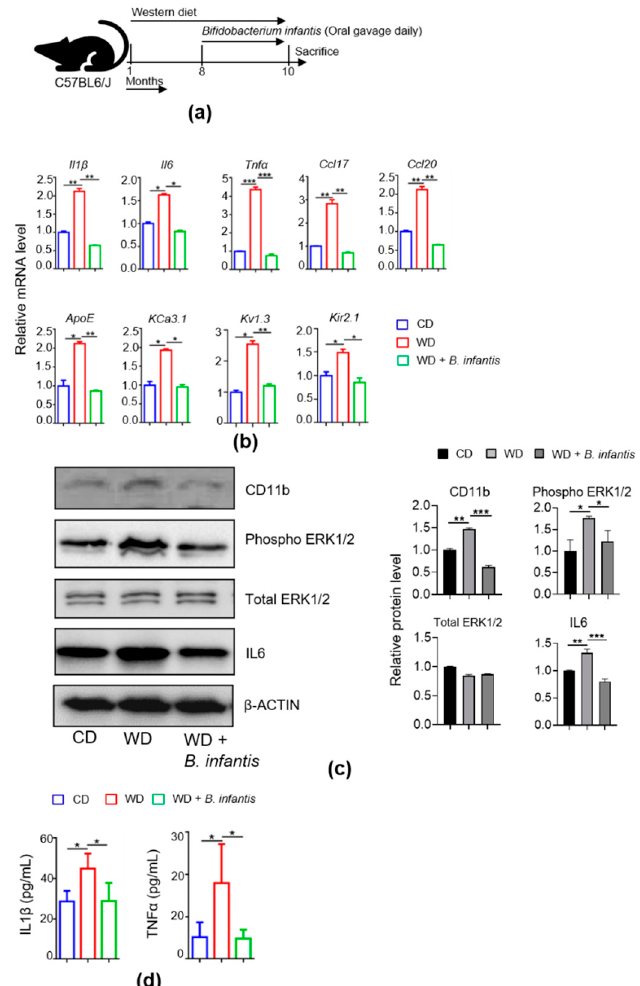
Figure 1. Probiotic B. infantis reduced brain inflammation signaling in WD-fed mice. ( a ) Experimental schema. ( b ) The hippocampal mRNA levels of inflammatory signaling genes of CD-fed (n = 6), WD-fed (n = 6), and WD-fed mice supplemented with B. infantis (n = 4). ( c ) Western blot of proteins related to inflammatory signaling. ( d ) Brain homogenate concentration of IL1 β and TNF α by ELISA (n = 3). Data are expressed as means ± SD. One-Way ANOVA multiple comparisons Tukey t -test, * p < 0.05, ** p < 0.01, *** p < 0.001. CD-fed mice vs. WD-fed mice; WD-fed mice vs. B. infantis supplemented